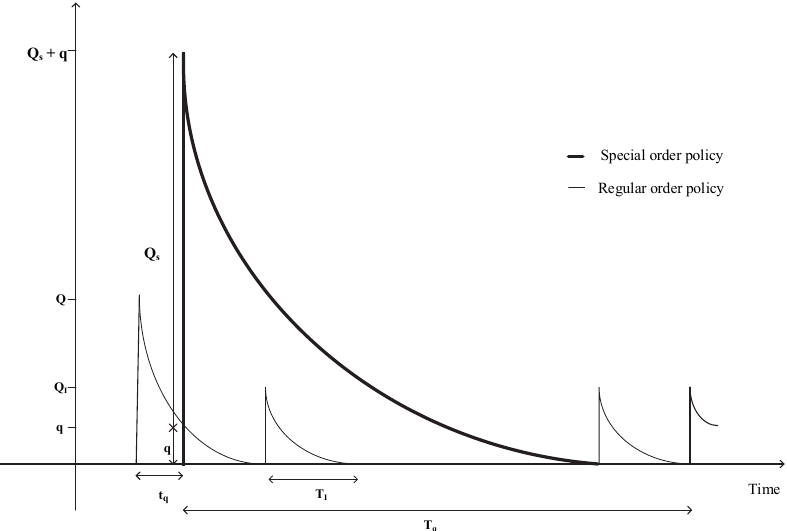
Fig. 2. Special vs. regular order policies when the special order time occurs during the retailer’s sales